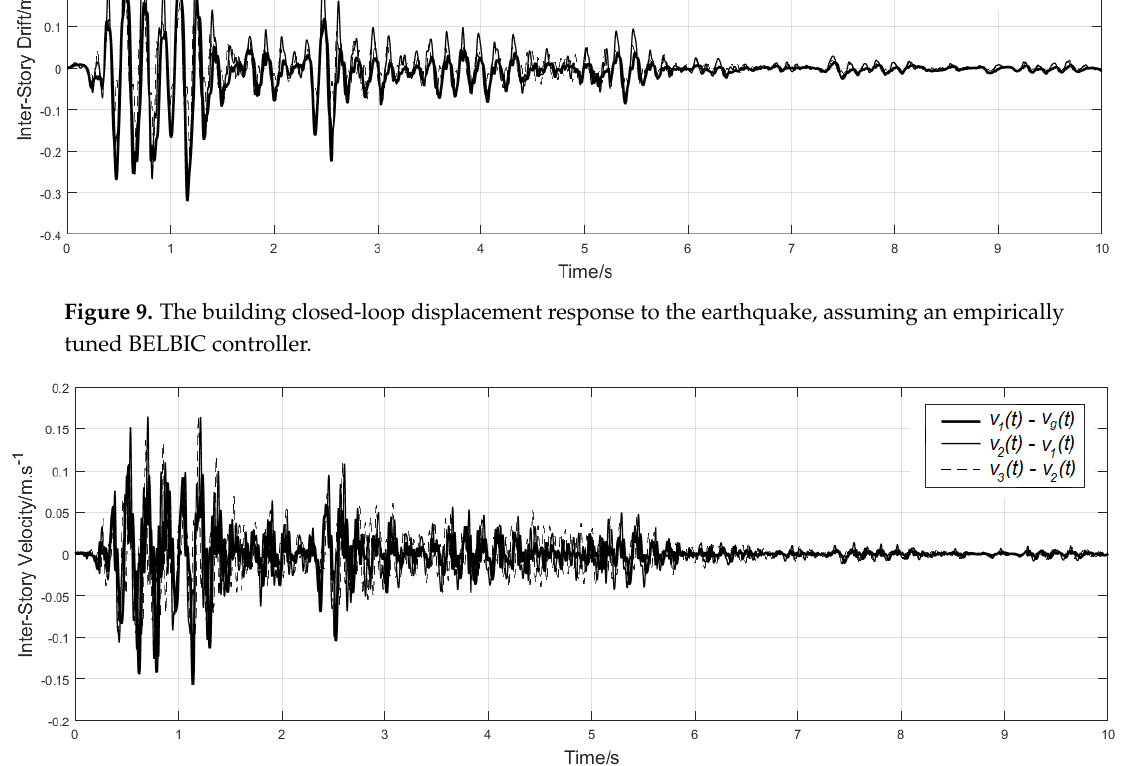
Figure 10. The building closed-loop velocity response to the earthquake, assuming an empirically tuned BELBIC